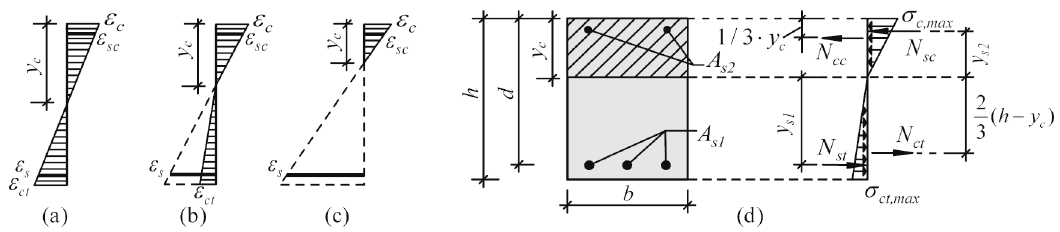
Fig. 3. Modelling a bending member: (a), (b), (c) assumed strain distribution in uncracked, arbitrary and cracked sections respectively; (d) internal forces